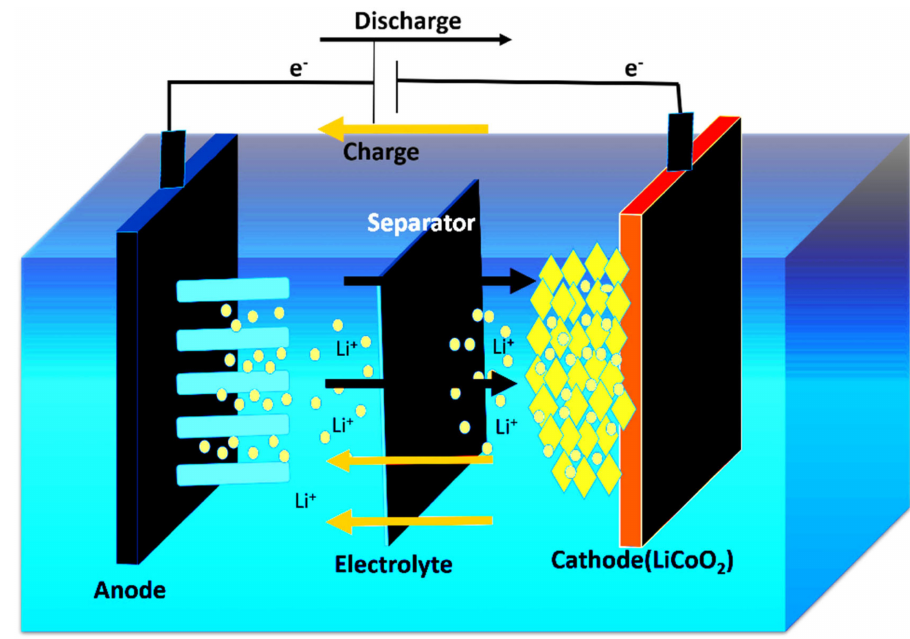
Figure 3. A skeleton of an LIB showing the Li + intercalation/deintercalation mechanism.